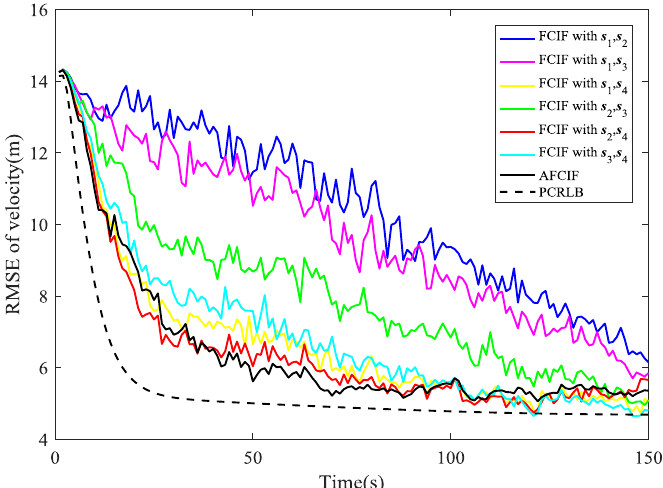
Figure 3. Comparison of RMSE (velocity estimation) when the initial process noise covariance is set to be larger than the true value. Sensors 2018 , 18 , x FOR PEER REVIEW